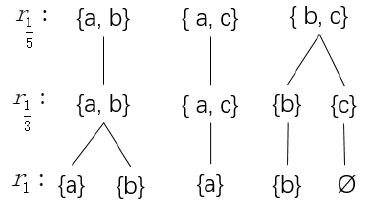
Figure 2. The tree structure of Example